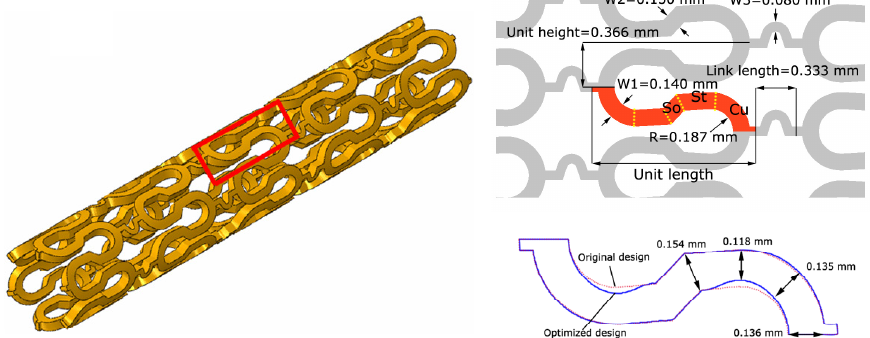
Figure 3: On the left: CAD model of the new conceptive stent in the original configuration In the box is indicated the one strut unit chosen for the optimization. On the upper right: 2D dimensions of the new conceptive stent. In red the strut unit for optimization. The unit is composed of curved (Cu), straight (St), and solidus (So) parts. On the lower right: optimized vs original design for ZM21 alloy